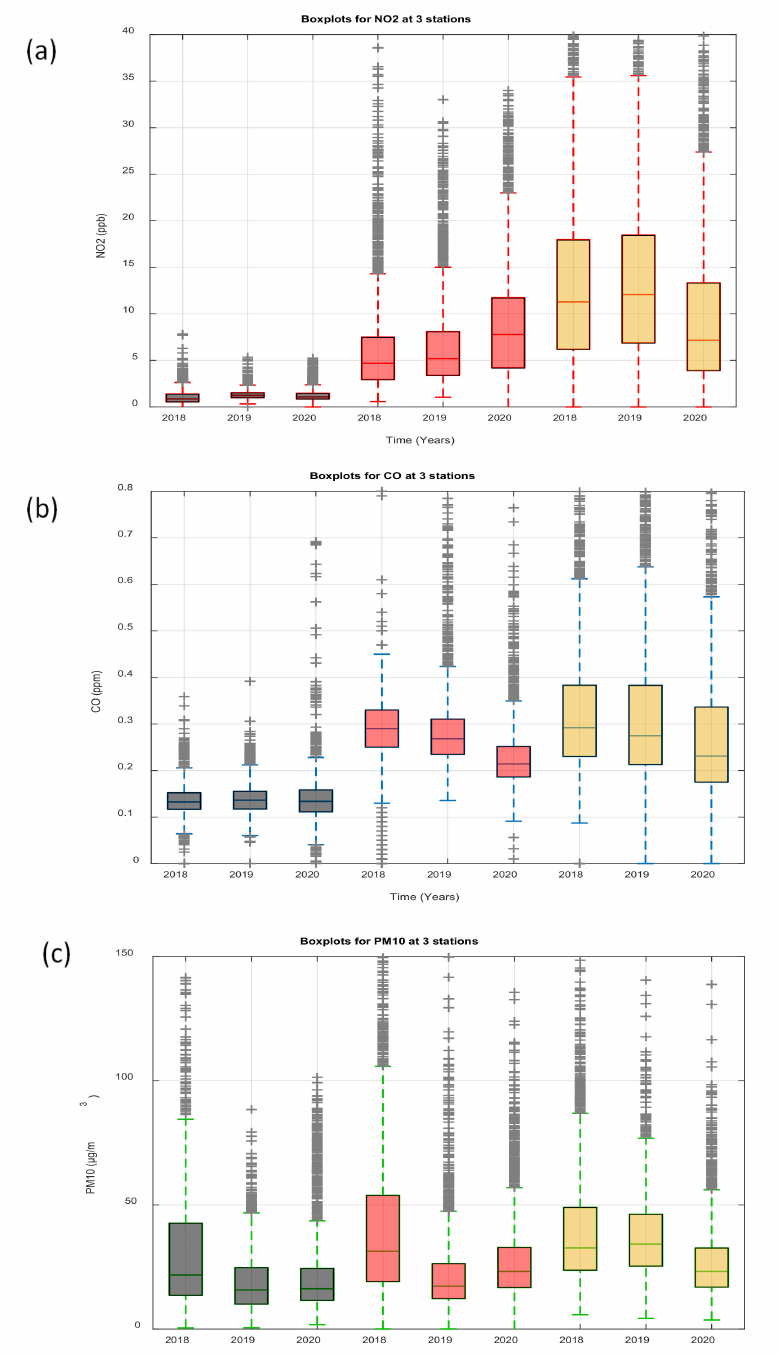
Figure 8. The box plots of the three pollutants concentrations: ( a ) NO 2 , ( b ) CO and ( c ) PM 10 at the three stations, AURA (red), AGM (black) and NicTr (orange), for the study periods in 2018, 2019 and 2020. The median is represented by the horizontal line in the middle of the rectangle, while the top and bottom lines of the rectangle represent the 25% and 75% percentiles; the grey crosses denote the extreme data